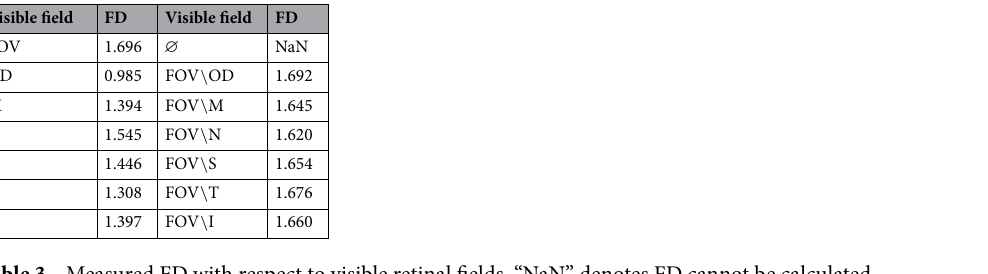
Table 3. Measured FD with respect to visible retinal fields. “NaN” denotes FD cannot be calculated.